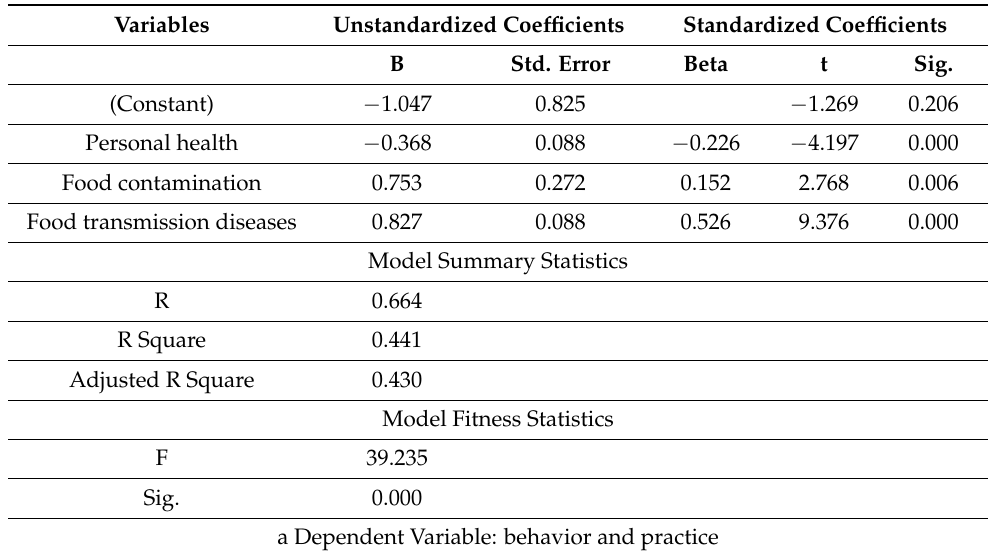
Table 9. Multiple regression on the influence of knowledge on practice of food safety and sanitation.